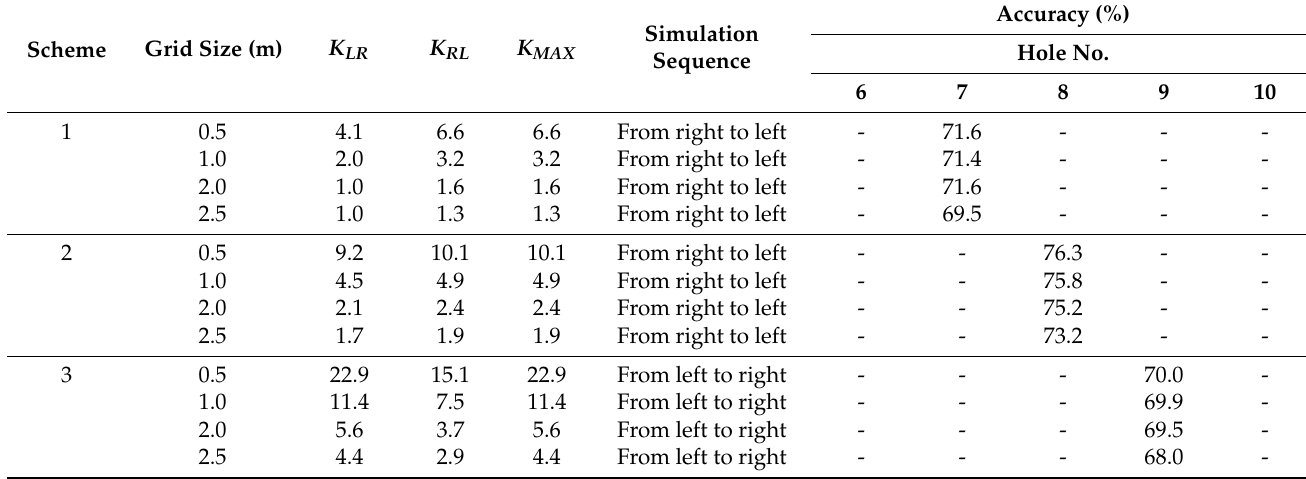
Table 7. Accuracy of the CMC model (100 cyc.) under different grid